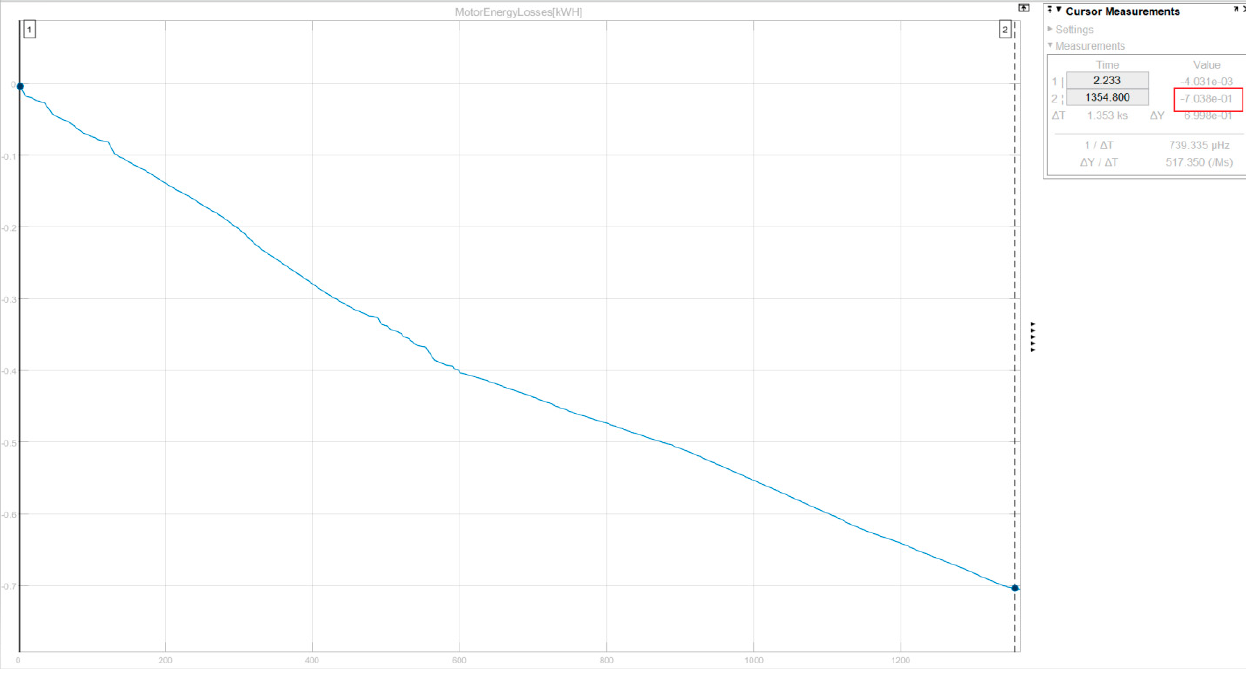
Figure 28. Motor energy losses over time.